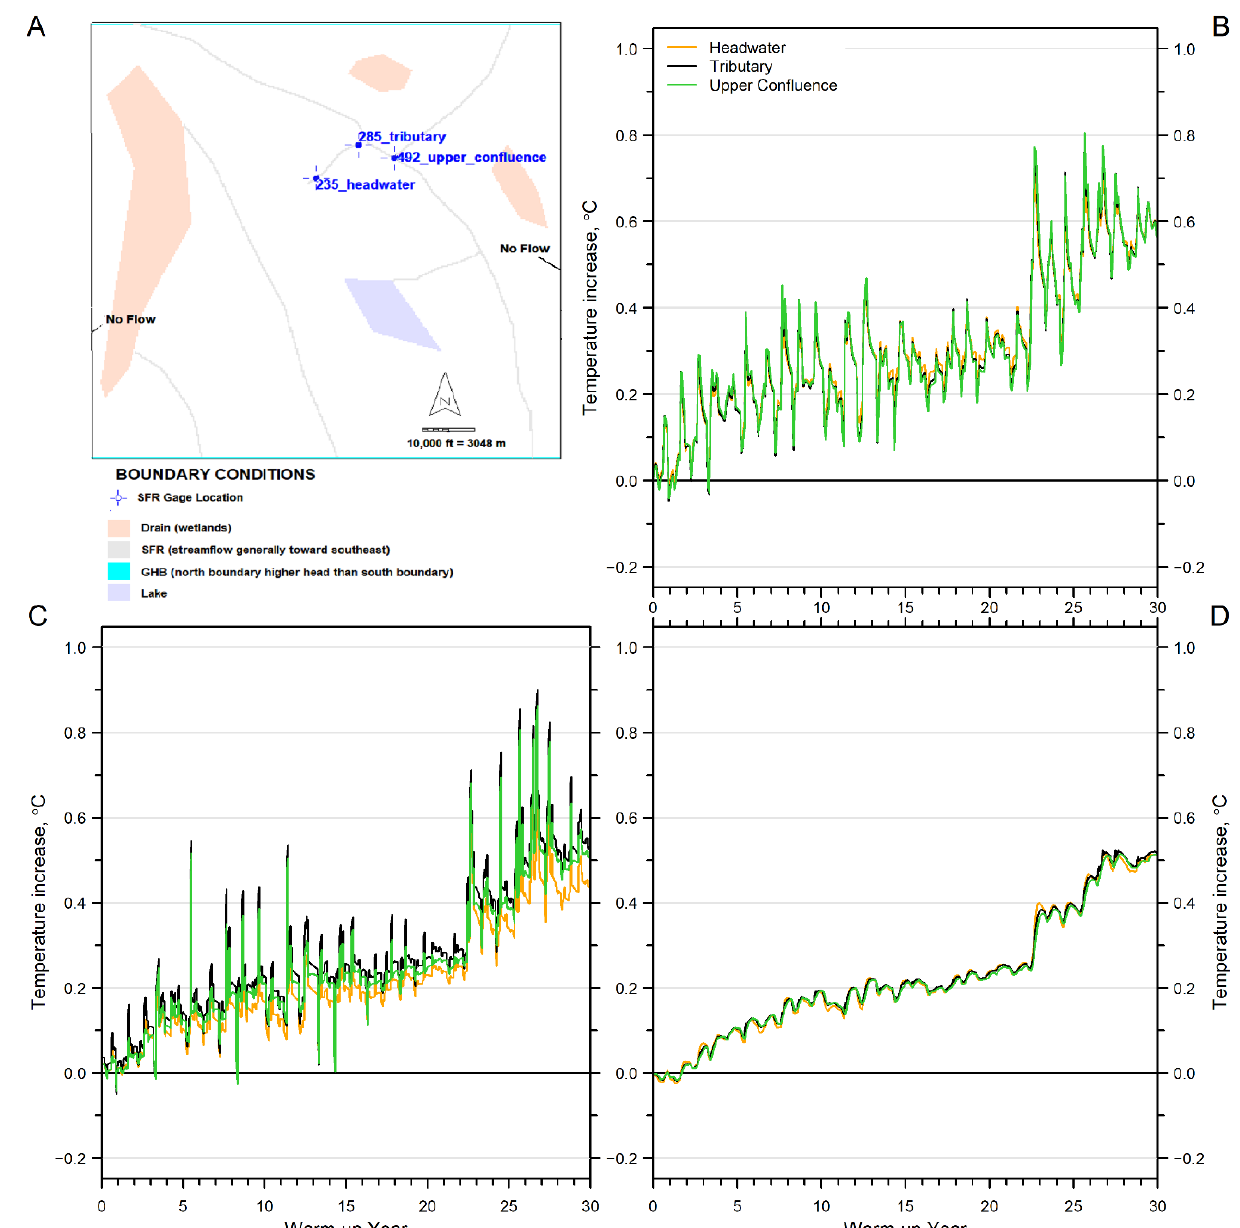
Figure 6. Simulated stream baseflow temperature response to warming ( A ) at the upgradient gage locations for the ( B ) NO_UZ_THK, ( C ) MID_UZ_THK, and ( D ) HI_UZ_THK model simulations. locations for the ( B ) NO_UZ_THK, ( C ) MID_UZ_THK, and ( D ) HI_UZ_THK model